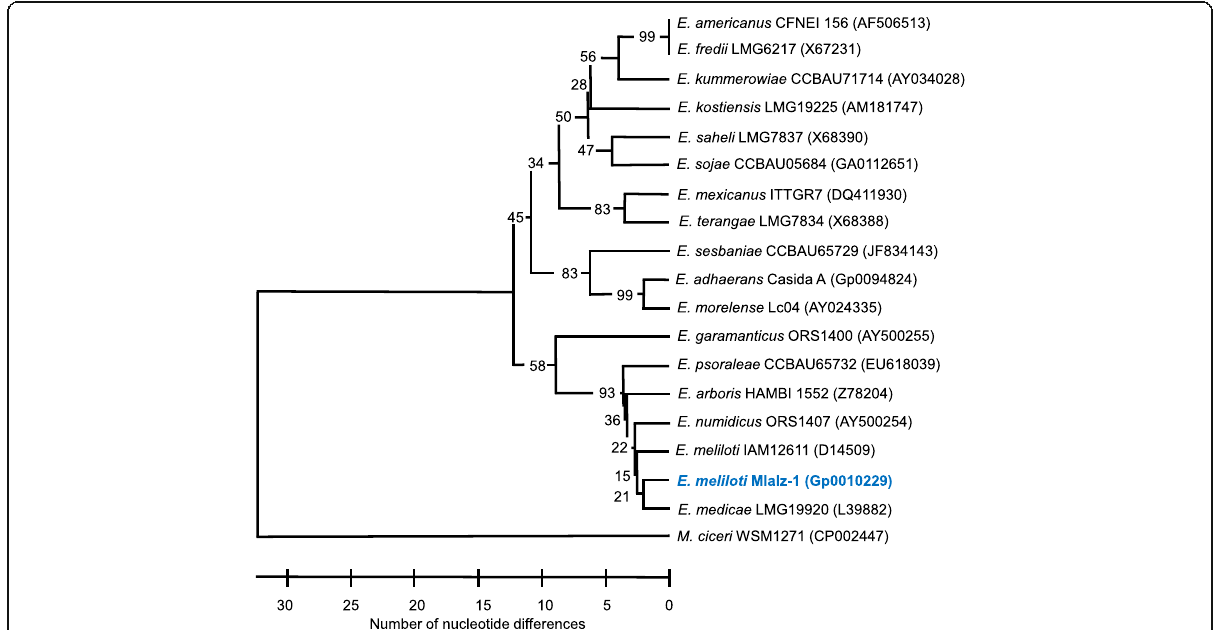
Fig. 2 Comparison of the 16S rRNA gene sequences of Ensifer meliloti Mlalz-1 (shown in bold) and other Ensifer spp. type strains, based on aligned 16S rRNA gene sequences of 1389 bp. Of the 1389 sites, 1279 were constant and 48 were informative. There were eight gaps overall when Mesorhizobium ciceri bv biserrulae WSM1271 was included in the analysis. Phylogenetic analysis was done using MEGA, version 6.0 [61] after manually assembling the alignment by using GeneDoc version 2.6.001 [62]. M. ciceri bv biserrulae WSM1271 was used as an outgroup and the tree was assembled using the UPGMA algorithm based on the number of nucleotide differences. This approach was used since the potential for genetic recombination among the different 16S rRNA genes as reported by van Berkum [63] cannot be ignored. Bootstrap analysis [64] with 2000 permutations of the data set was done to assess support for the branch points. Strains with a genome sequencing project registered in GOLD [24] are Ensifer adhaerens Casida A T , M. ciceri bv. biserrulae WSM1271 and Mlalz-1 and the GOLD ID is provided in